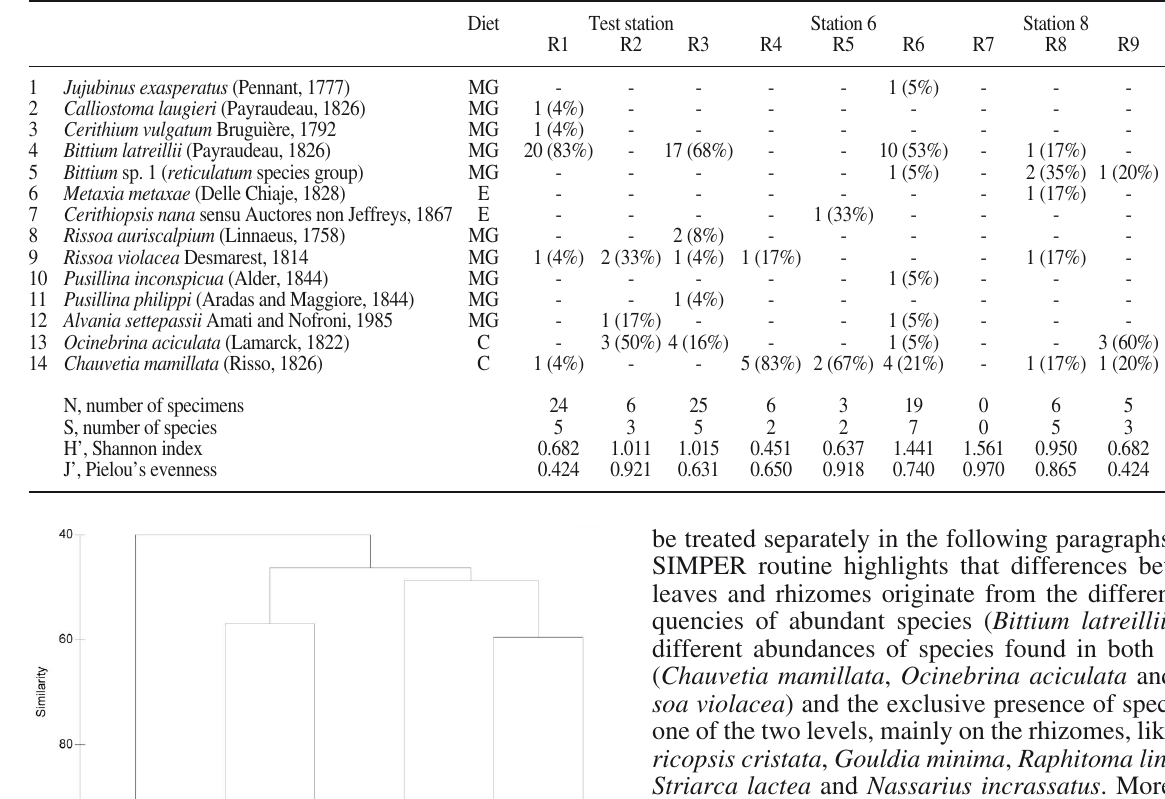
Table 2. – Faunistic list of molluscs found on the Posidonia leaves with quantitative data. The total number of individuals in each sample, the dominance index %D (between brackets), the frequency %F and the feeding guild code are given (C carnivores feeding on mobile organisms; SC scavengers; D deposit feeders; E ectoparasites and specialized carnivores; F filter feeders; AG macroalgae grazers; SG seagrass grazers; MG microalgal or periphyton grazers; O oophagus feeders; SY symbiont-bearing species). Biodiversity indices are reported at the bottom of the table.